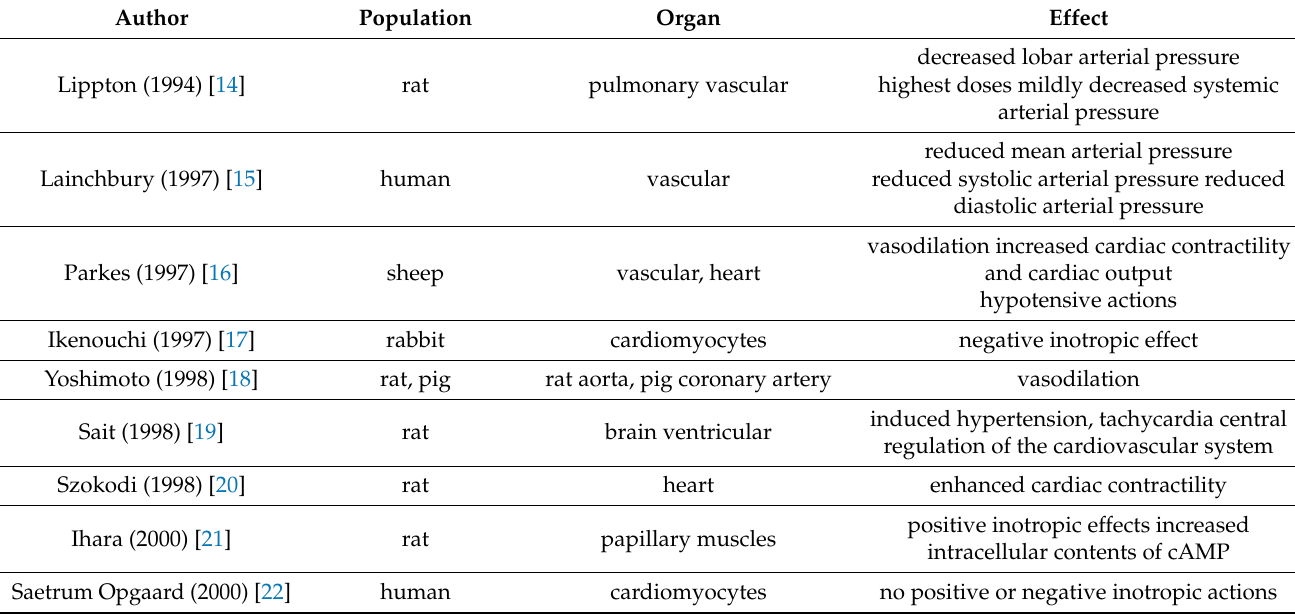
Table 1. Studies evaluating effects of ADM on cardiovascular